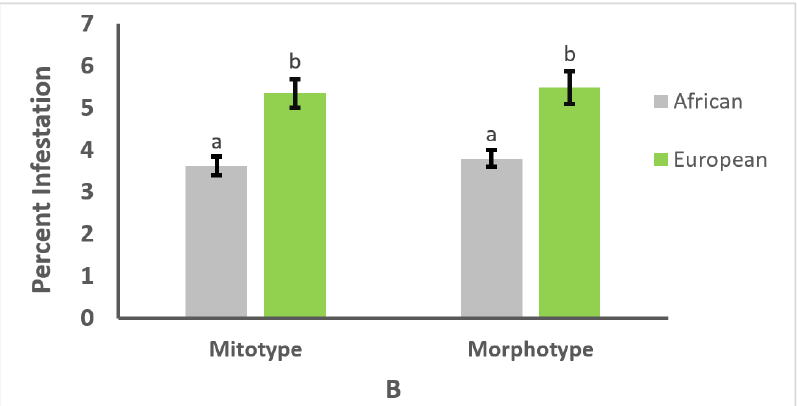
Figure 1. Percentage (±SE) of comb cells containing honey bee brood ( A ) or adult bees ( B ) of African or European mitotype or morphotype that were infested with Varroa destructor in 339 colonies. Different letters (a, b) above bars indicate significant differences between means, based on Wilcoxon tests.